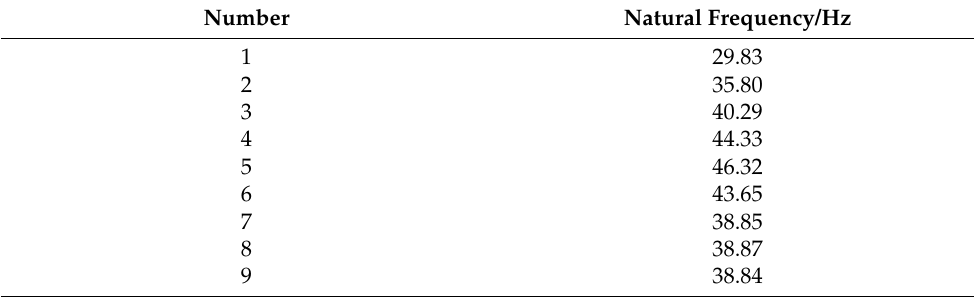
Table 4. Natural frequencies remeasured of workpieces in Table 2.